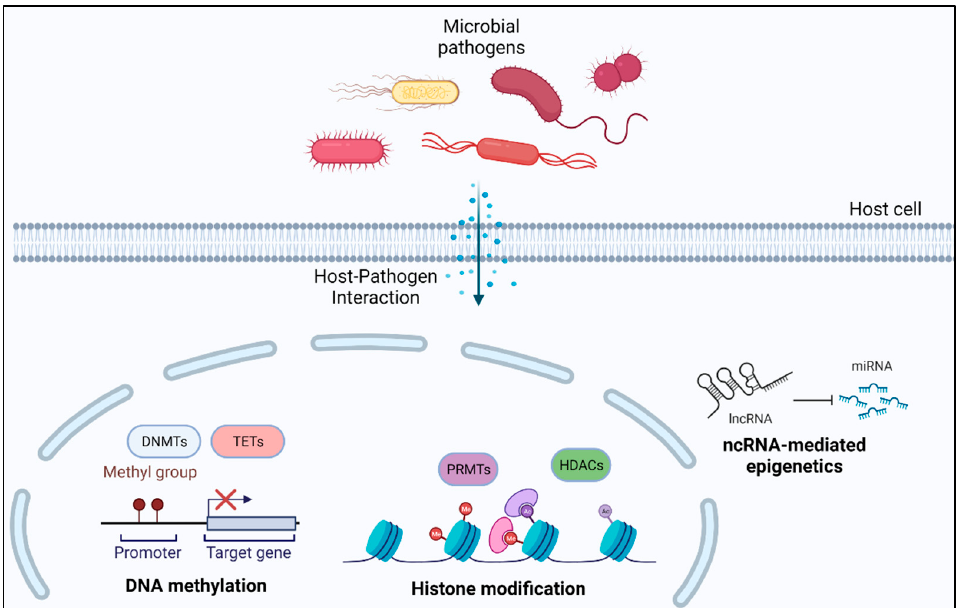
Figure 3. Bacteria-mediated epigenetic alterations in human host cells.